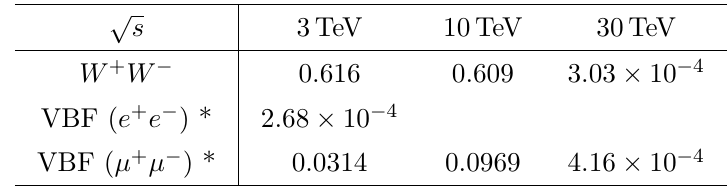
Table 1. The cross sections, in fb, for the background processes at various center of mass energies after all the selection cuts described in the